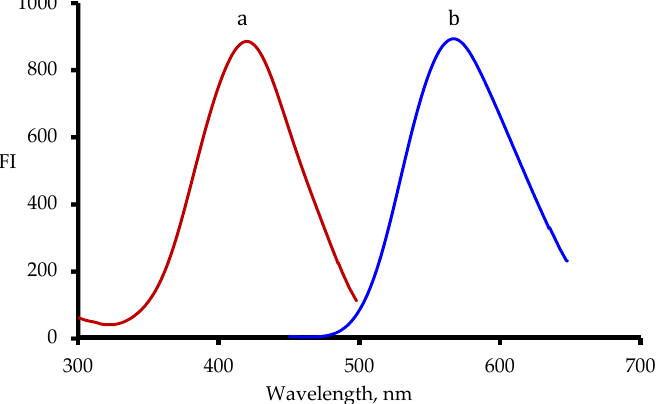
Figure 4. Evaluating the peroxidase activity for PVP-AgNPs on an OPD/H 2 O 2 system by fluorescence technique; ( a ) excitation spectrum for ox-OPD and ( b ) emission spectrum for ox-OPD.